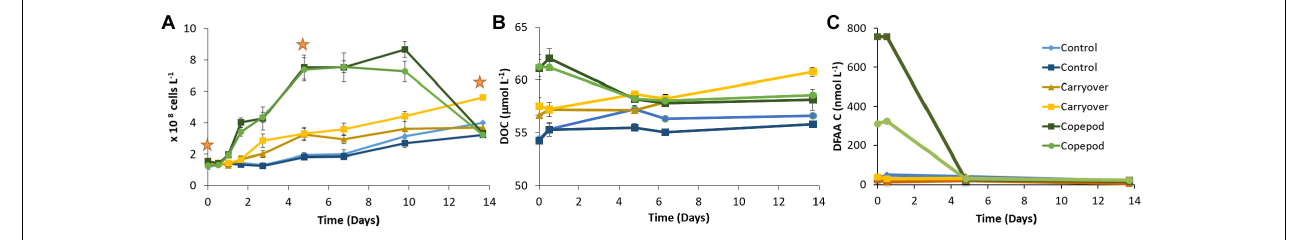
FIGURE 3 | Change in DAPI cell counts ± SD (A) , DOC ± SD (B) , and DFAA + Tau C (C) over the time course of the remineralization experiment (1620-2). DNA for metabarcoding of the prokaryotic community was collected at three time points [orange stars; (A) ].